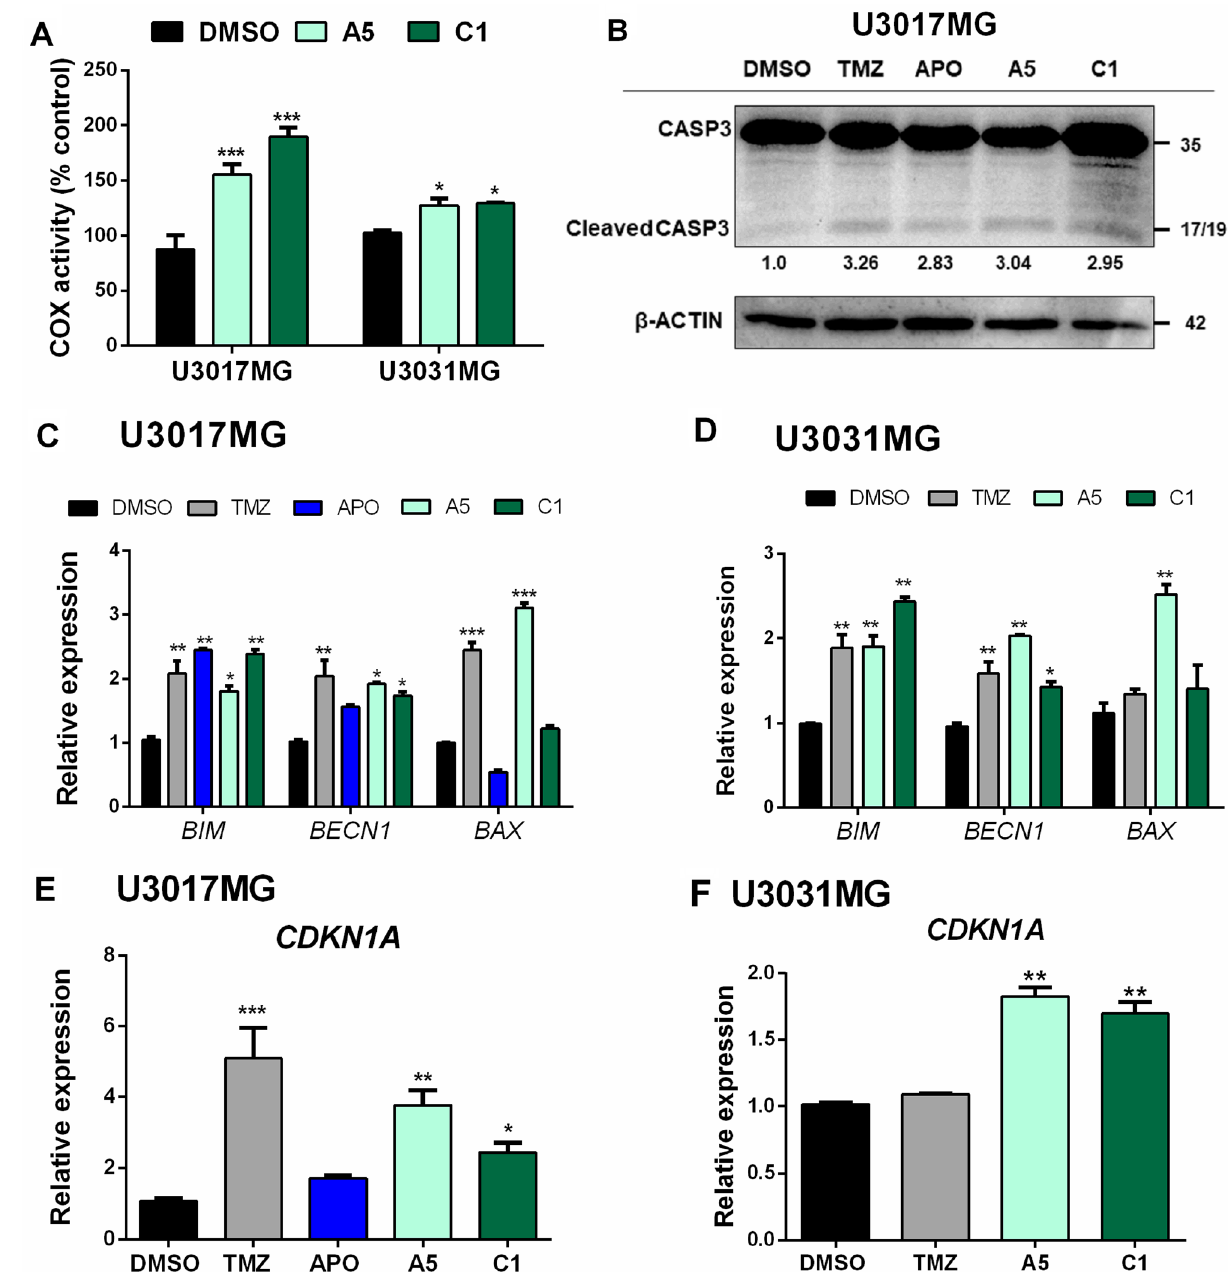
Figure 2. Treatment with aporphine and isoquinoline derivatives induce an intrinsic apoptosis cell death. ( A ) COX activities of GBM cells after 24 h of incubation with A5 (30 μM) or C1 (30 μM). Results are expressed as percentage of cell control treated with DMSO. ( B ) Representative immunoblot of cleaved caspase-3 in U3017MG cells treated with TMZ, APO, A5 or C1 for 48 h. β-Actin was used as a loading control, and molecular mass (kDa) markers are indicated along with densitometric values of normalized band intensity. ( C, D ) RT-qPCR was used for detection of markers for cell death mediated by apoptosis: BIM , BECN1 and BAX in U3017MG ( C ) and U3031MG ( D ) cells treated with DMSO, TMZ (150 µM), APO (25 µM), A5 (30 µM) or C1 (30 µM) for 48 h. TMZ, an alkylating agent frequently used as chemotherapy in GBM patients, was used as the positive control. ( E, F ) RT-qPCR was used for detection of DNA damage response gene expression: CDKN1A ( p21 ) in U3017MG ( E ) and U3031MG ( F ) cells treated with DMSO, TMZ (150 µM), APO (25 µM), A5 (30 µM) or C1 (30 µM) for 48 h. All the relative expression levels were normalized to GAPDH expression and calculated using the 2 −ΔΔCt method. Error bars represent SD from three biological replicates and p values were calculated according to the two-way ANOVA test followed by Bonferroni (post-test); * p < 0.05, ** p < 0.01, *** p <